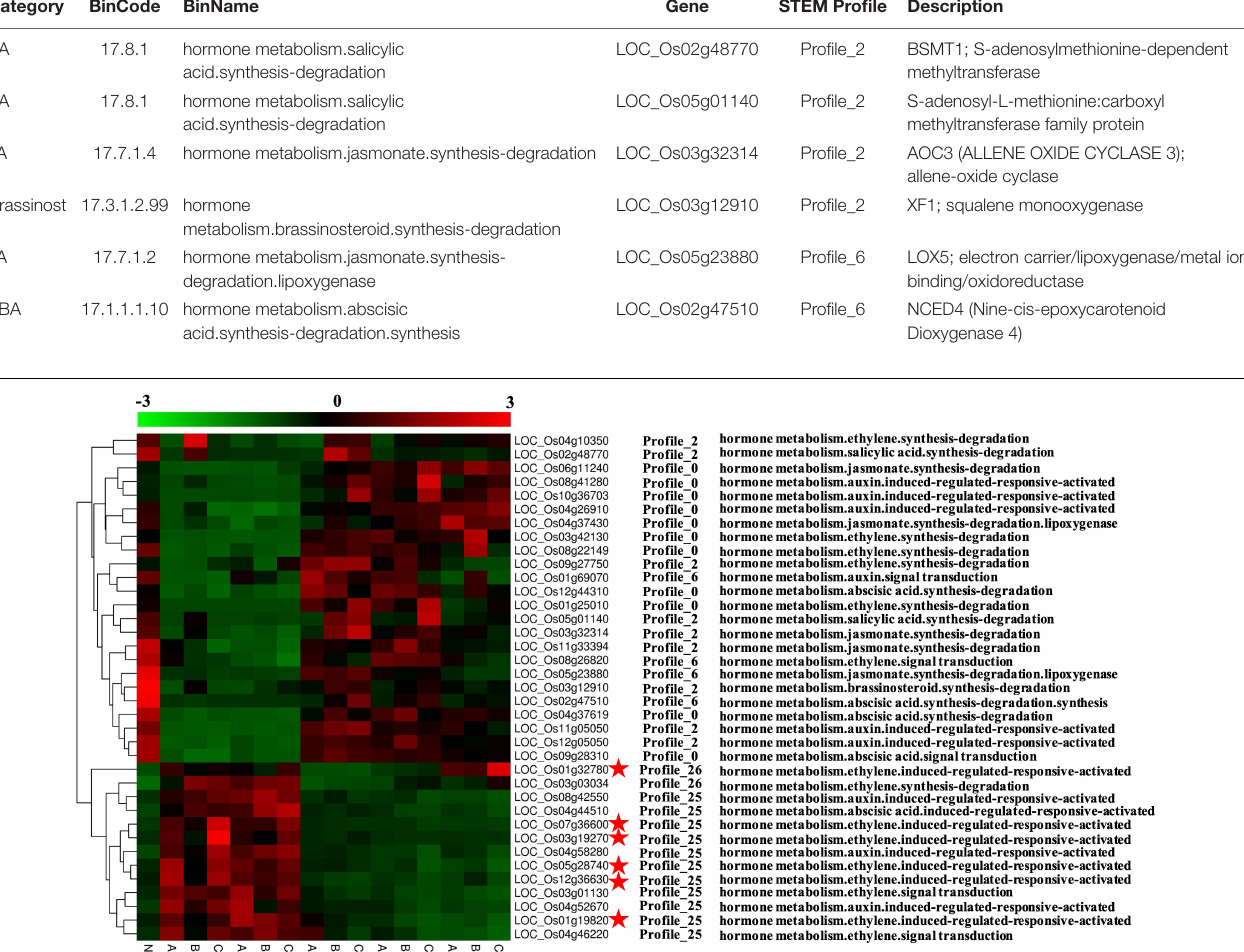
inoculated by M. oryzae 248, 235, and 162. As